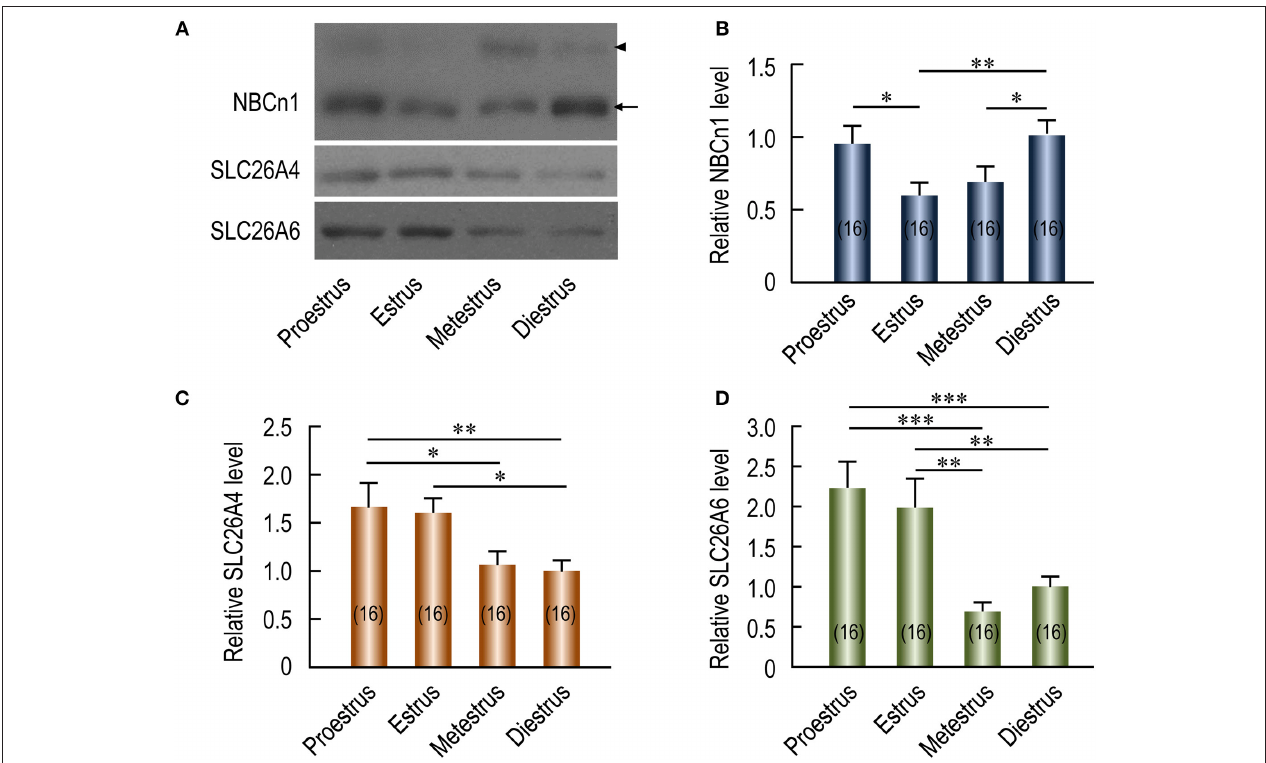
FIGURE 3 | Effect of estrous stages on expression of NBCn1, SLC26A4, and SLC26A6 in mouse uteri. (A) Representative western blotting of NBCn1, SLC26A4, and SLC26A6 in mouse uteri at different estrous stages. (B,D) Summary showing the relative abundance of uterine NBCn1 (B) , SLC26A4 (C) , and SLC26A6 (D) in mouse uteri at different estrous stages. In A , each lane represents the uterus from a single mouse. Equal amount (10 µ g) of total membrane proteins were loaded into each lane on the same gel for western blotting analysis. Equal loading was verified by Coomassie staining (see details in Supplementary Figures S4D–F). Full-length blots for the images in A are shown in Supplementary Figures S4A–C. To create the bar graphs, raw densitometric density was obtained for the target band in each lane on a specific blot by using ImageJ. The density of the “diestrus” lanes on this blot was averaged. The raw densitometric density of each individual lane was then divided